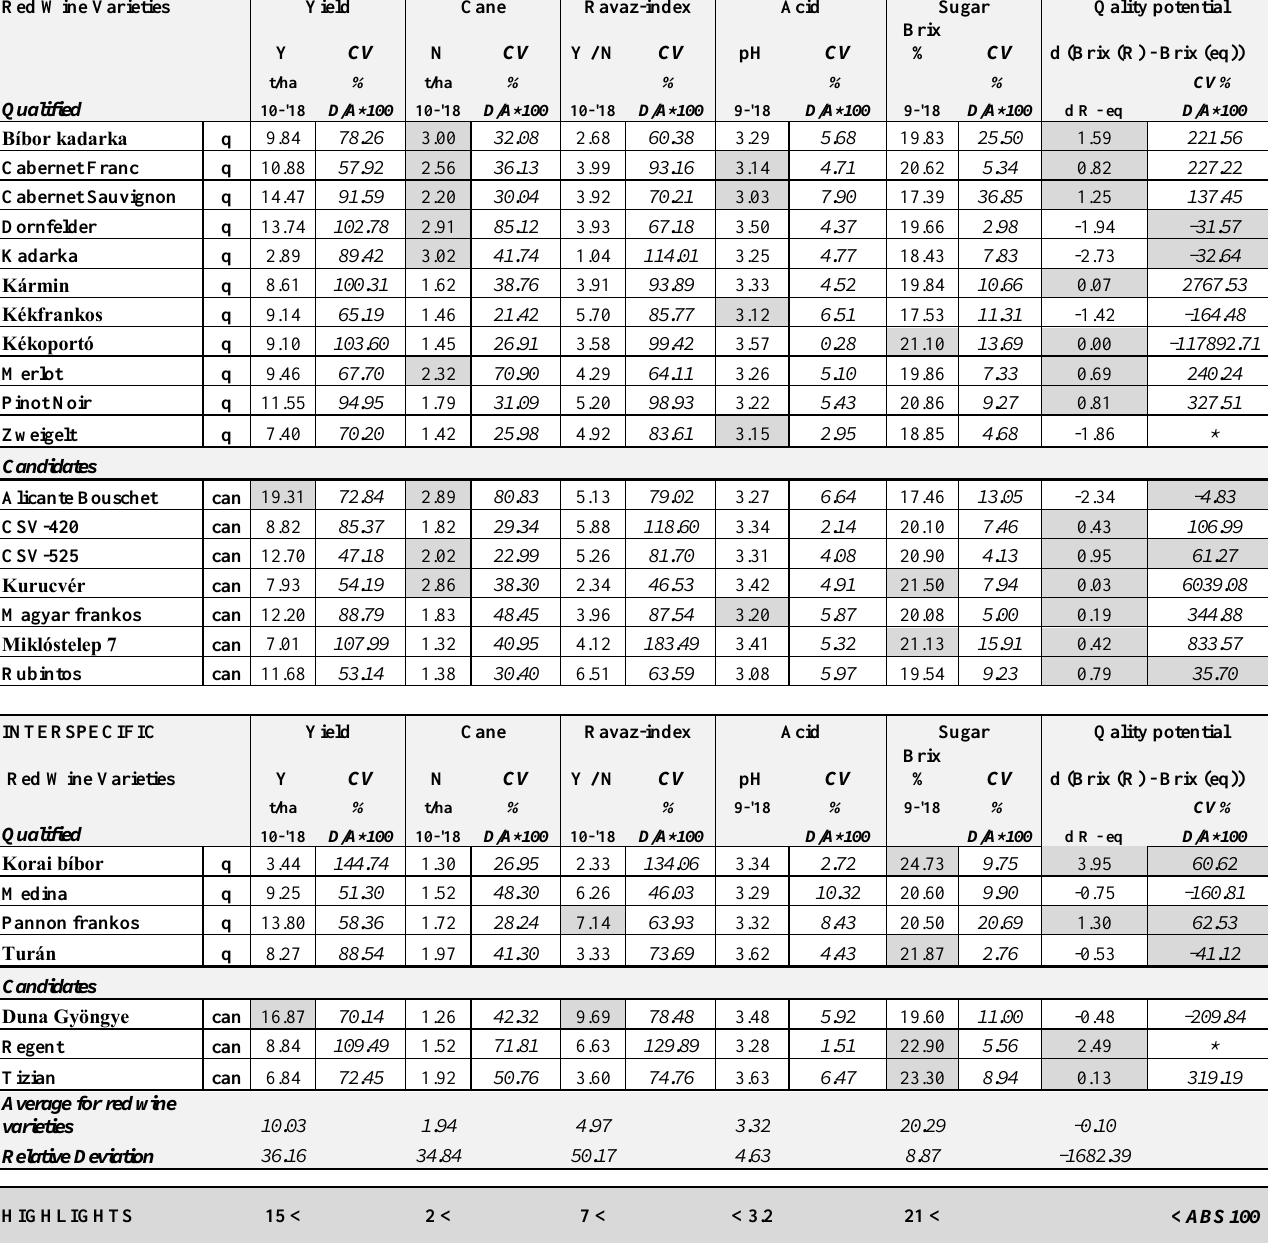
Table 4. Production and flexibility data of red wine grape varieties (Pallag,